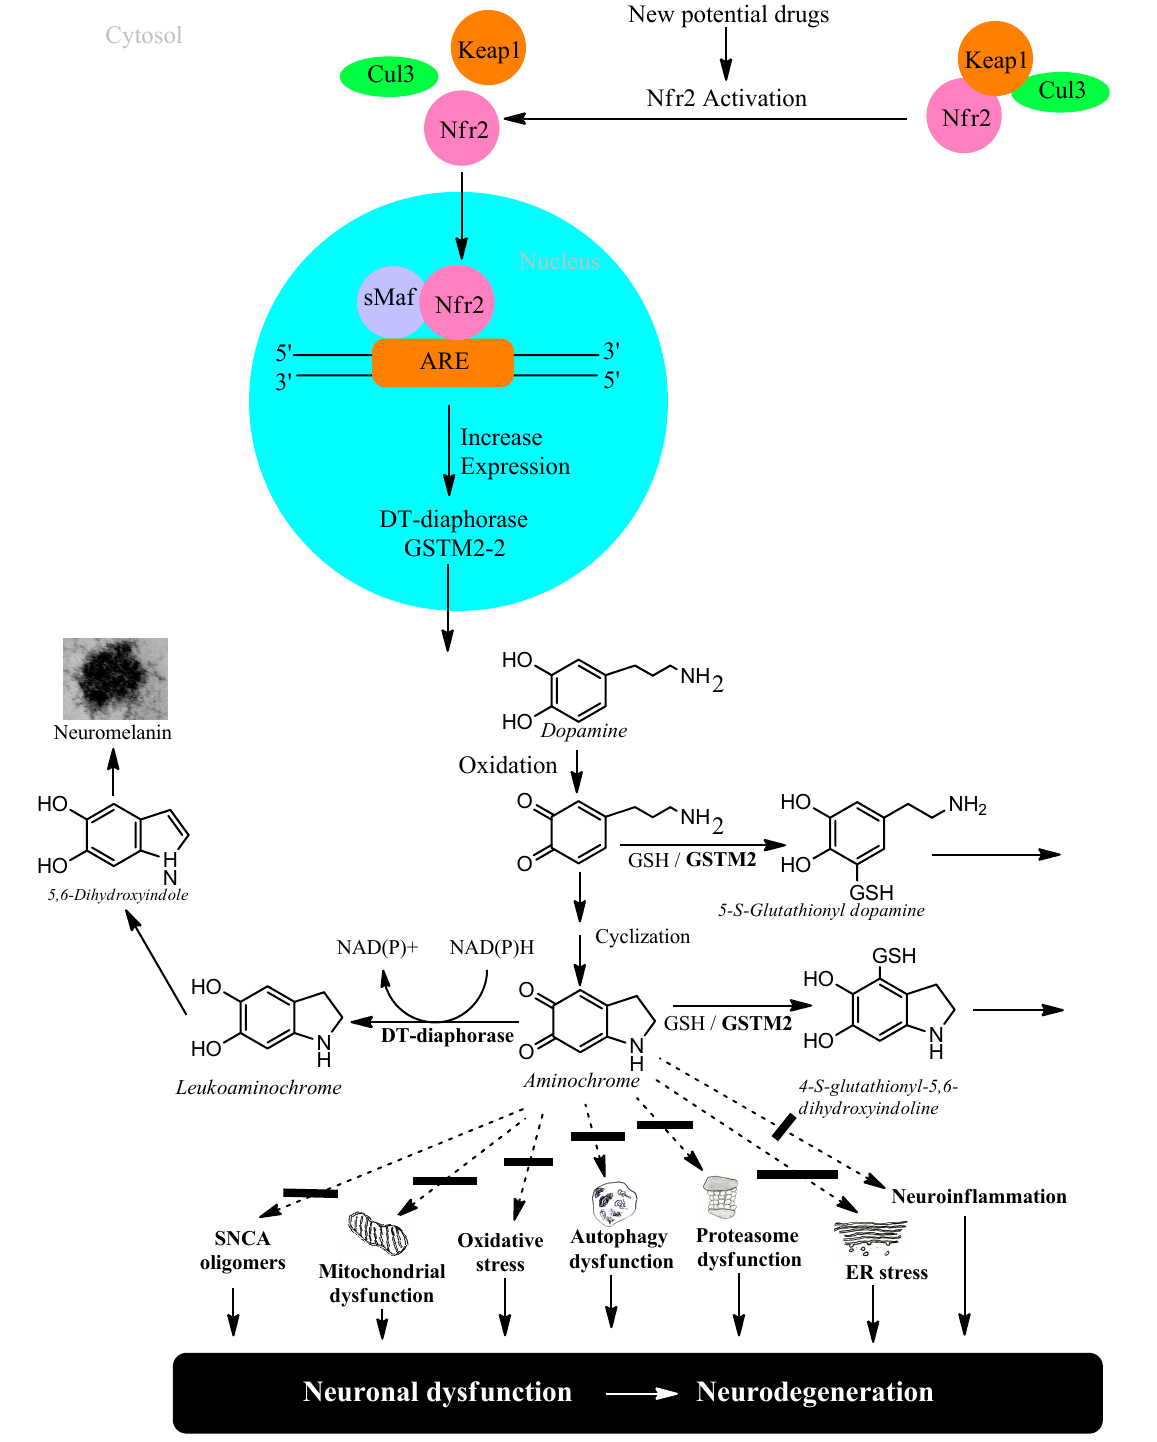
Figure 2. NFR2 activation to protect dopaminergic neurons from aminochrome